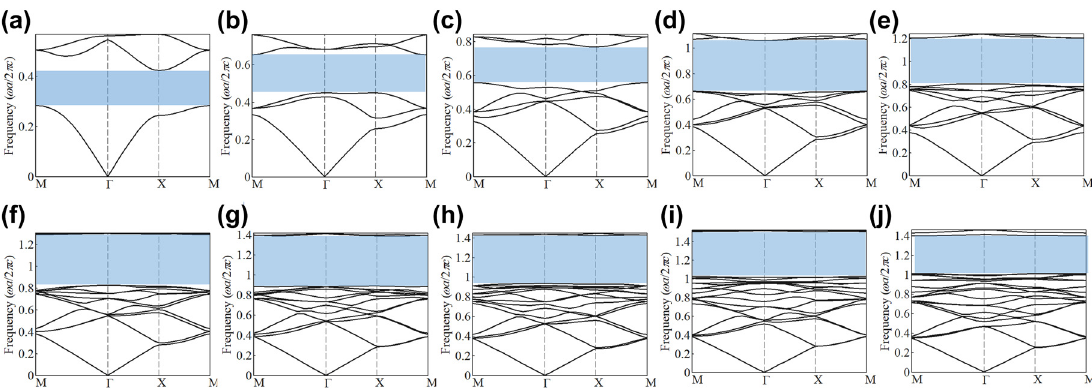
Figure2: ThebanddiagramsoftheoptimizedPCshostingdifferentodd-orderbandgaps(shadedbylight-blueregions):(a)thefirst-order;(b) the third-order; (c) the fifth-order; (d) the seventh-order; (e) the ninth-order; (f) the eleventh-order; (g) the thirteenth-order; (h) the fifteenth- order; (i) the seventeenth-order; (j) the